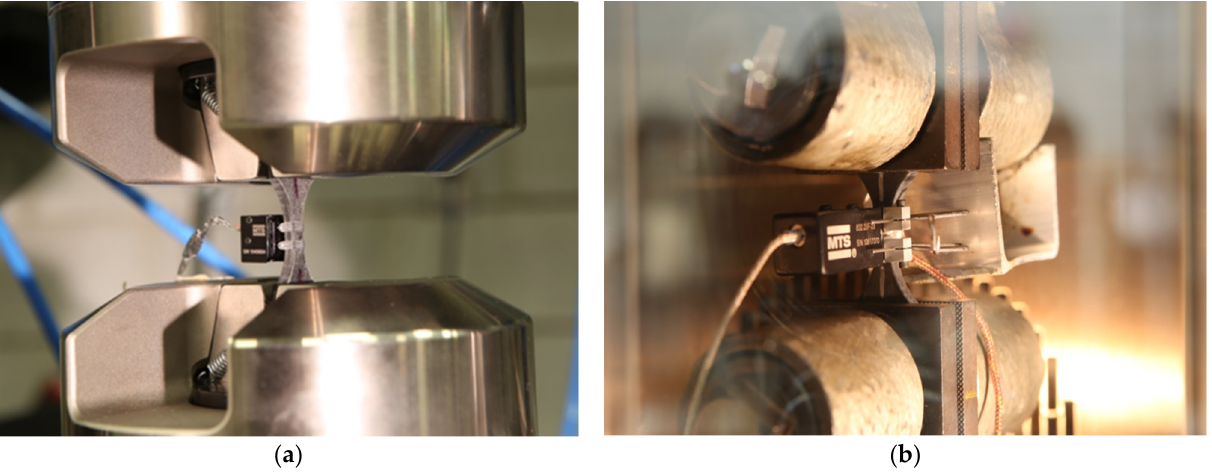
Figure 2. Fatigue test setup for: ( a ) room temperature testing; ( b ) elevated temperature in an environmental chamber.